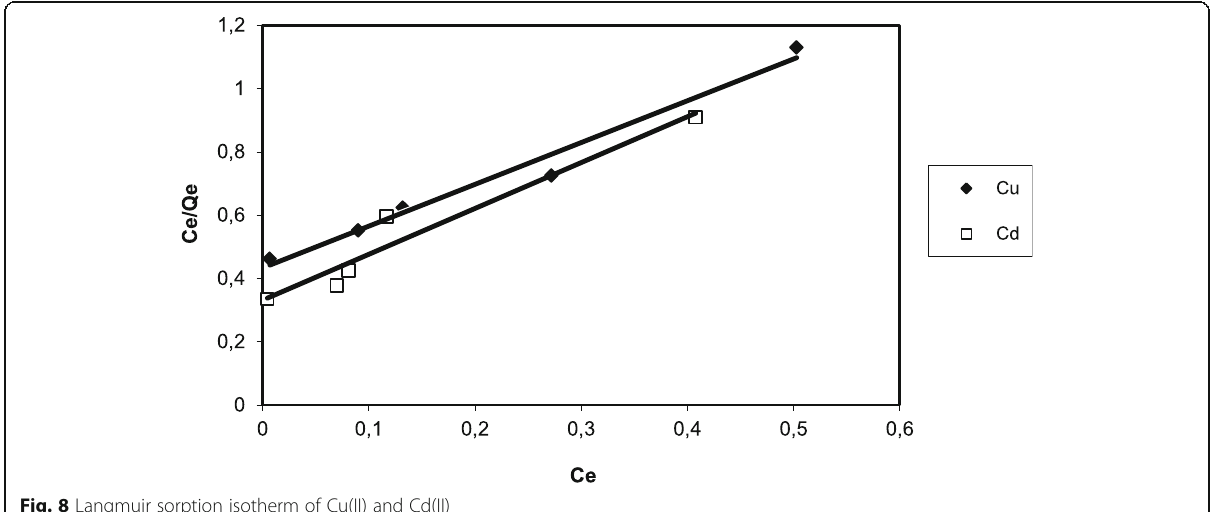
Fig. 8 Langmuir sorption isotherm of Cu(II) and Cd(II)